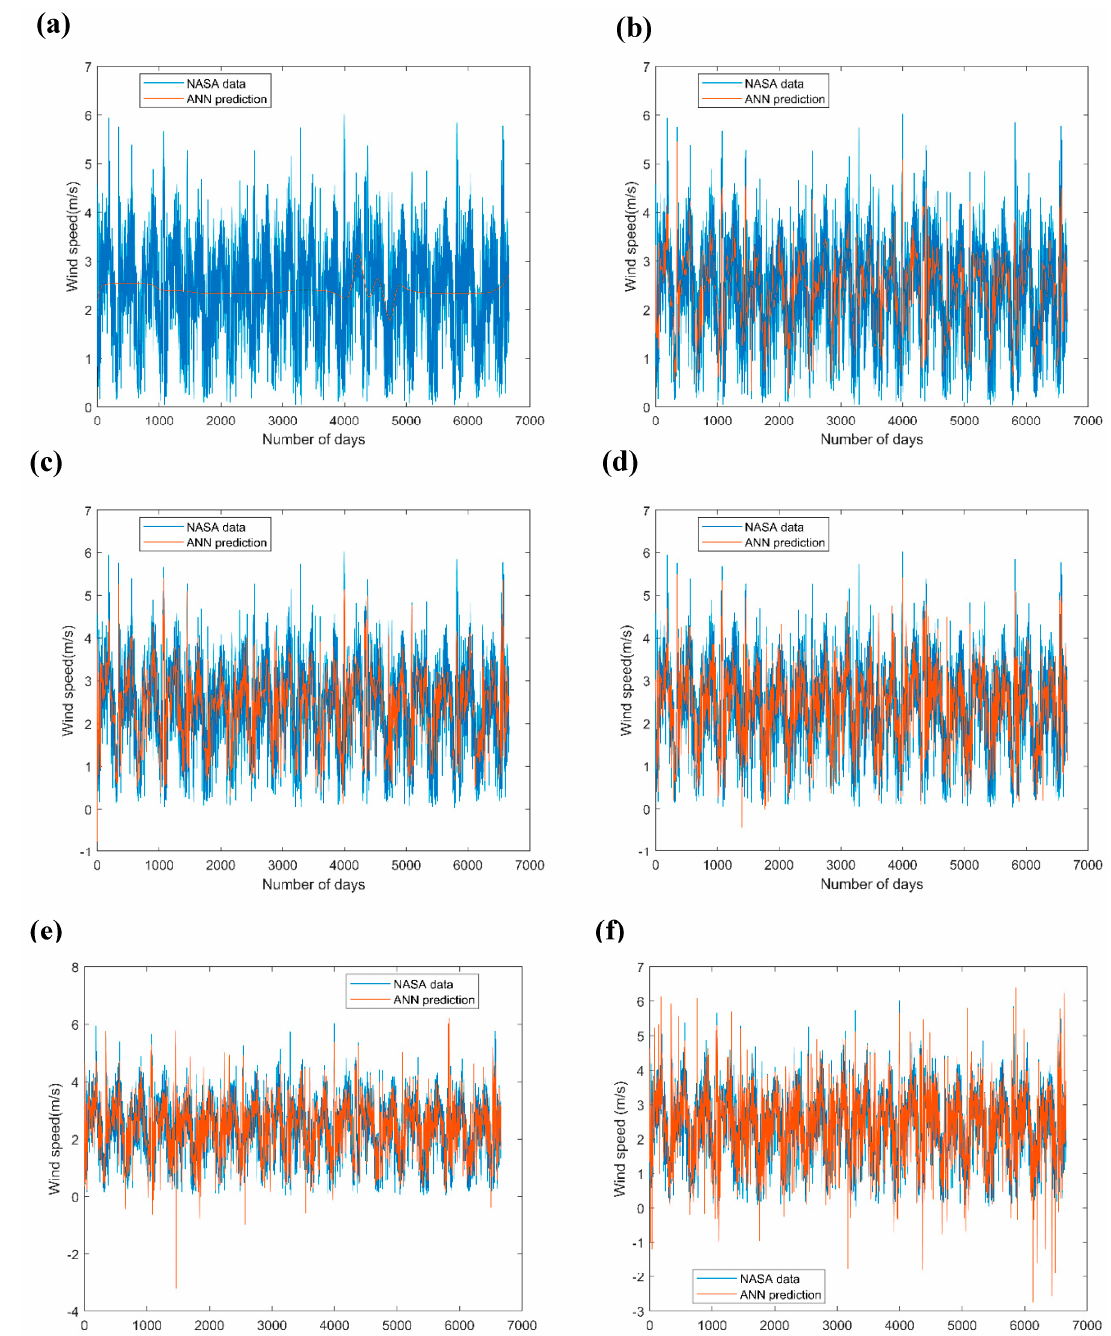
Figure 7. Wind speed plot of the NASA data vs. the ANN model with ( a ) 10 hidden units, ( b ) 500 hidden units, ( c ) 1000 hidden units, ( d ) 1500 hidden units, ( e ) 2000 hidden units, and ( f ) 2500 hidden units.